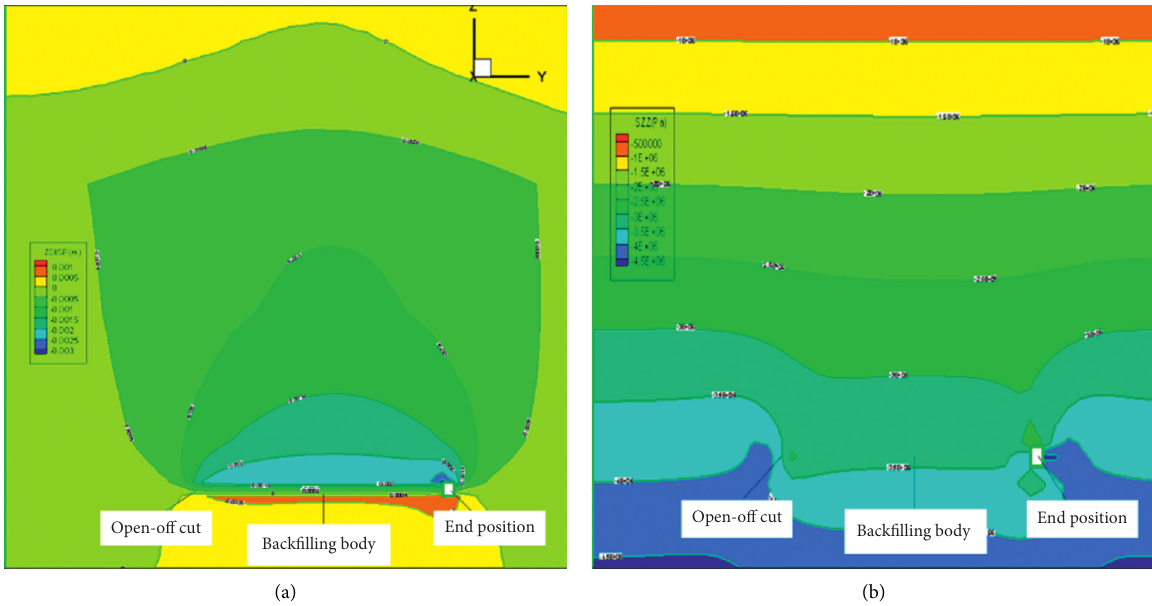
Figure 11: Movement of overlying strata when the working face advances for 100m under the elastic modulus of gangue of 5GPa. (a) Displacement vector of surrounding rock. (b) Distribution of vertical